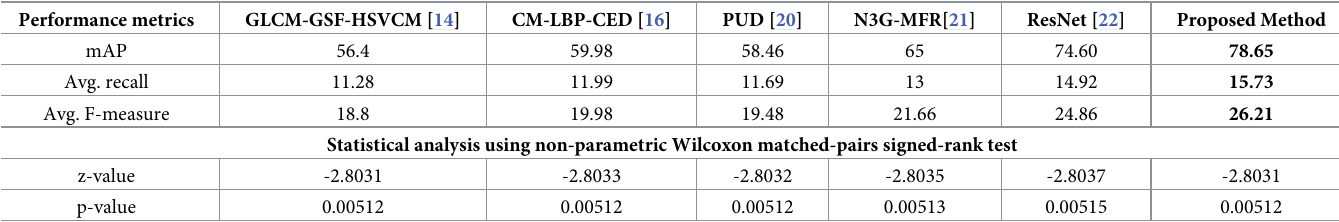
Table 4. Performance comparison of the proposed method with state-of-the-art methods on the Wang 10k dataset. Performance metrics